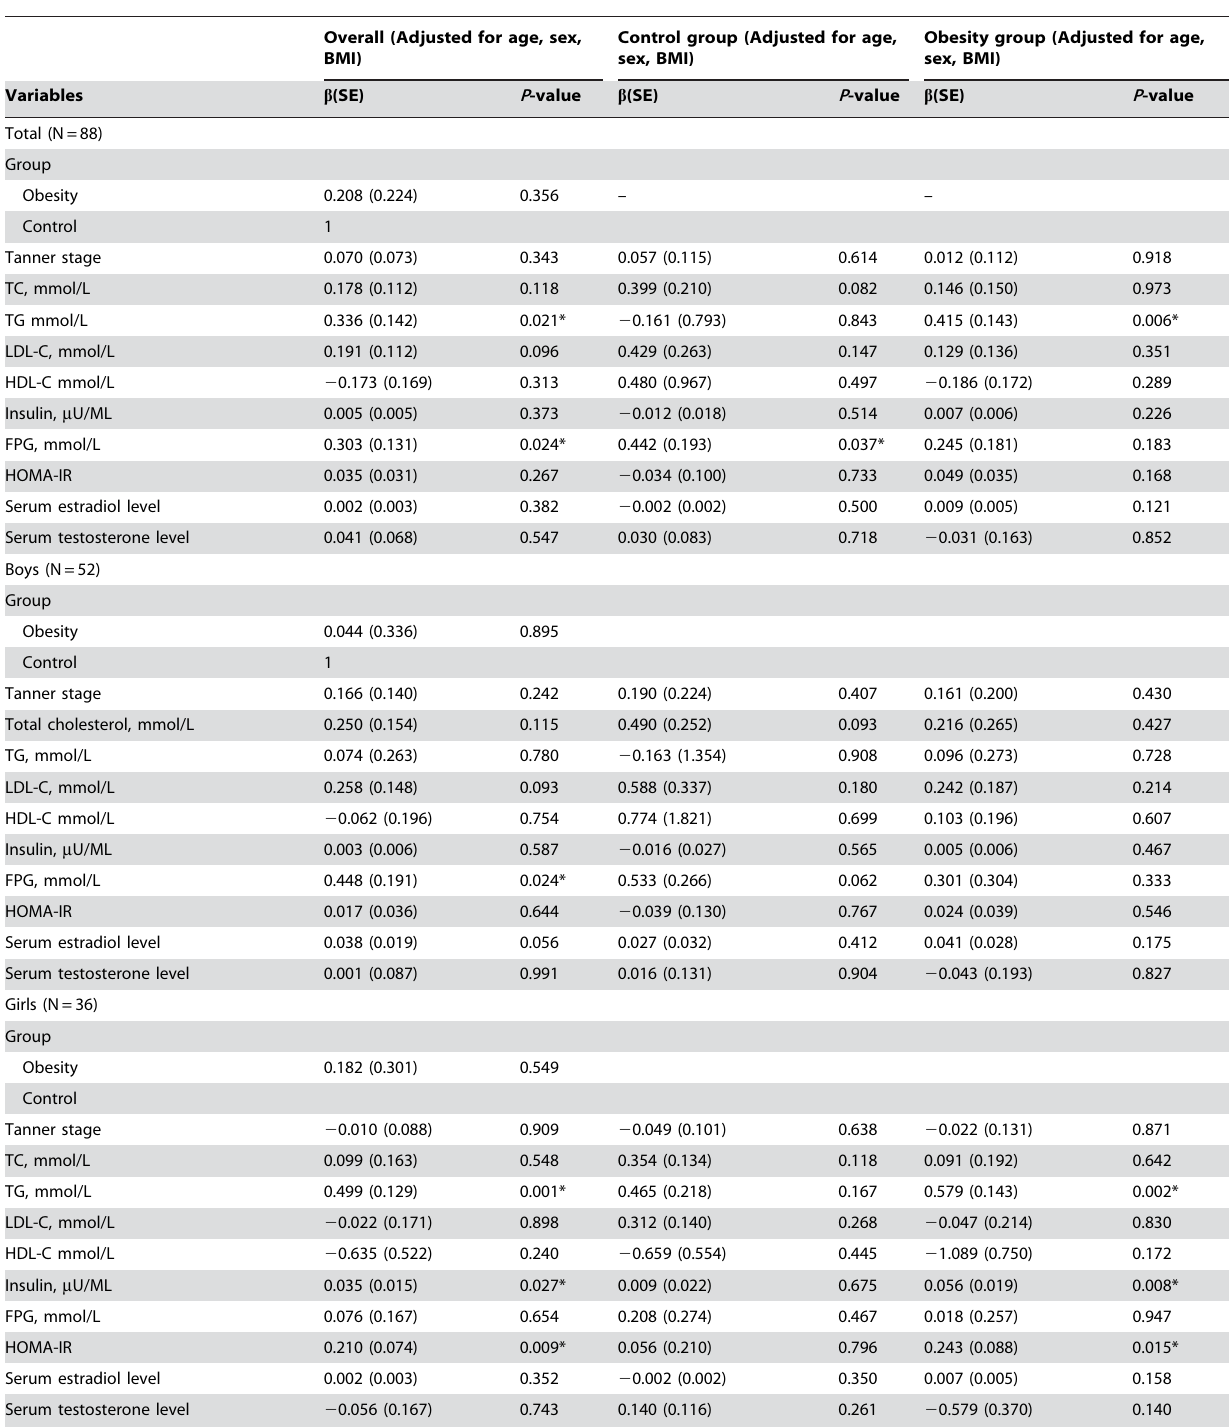
Table 3. Linear regression analysis of associations of apelin-12 levels with obesity-related markers.